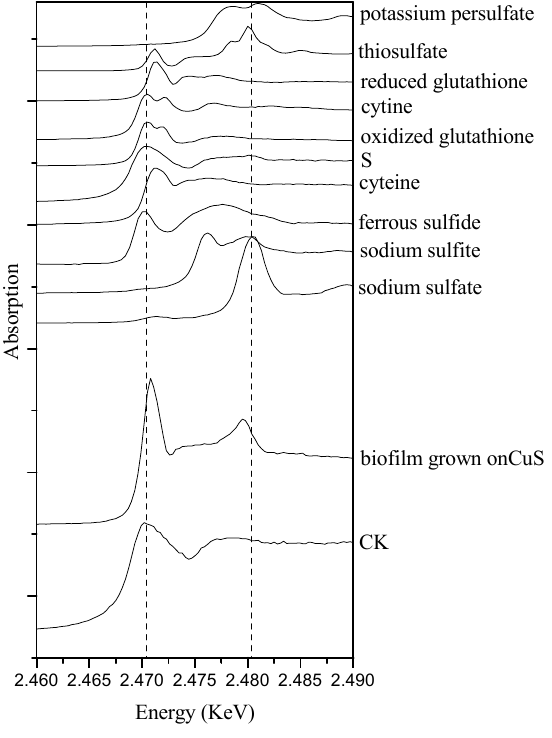
Figure 4. Comparison of sulfur K-edge XANES in Halothiobacillus HT1 biofilm (CK), Halothiobacillus HT1 biofilm reacted with CuS and reference compounds.